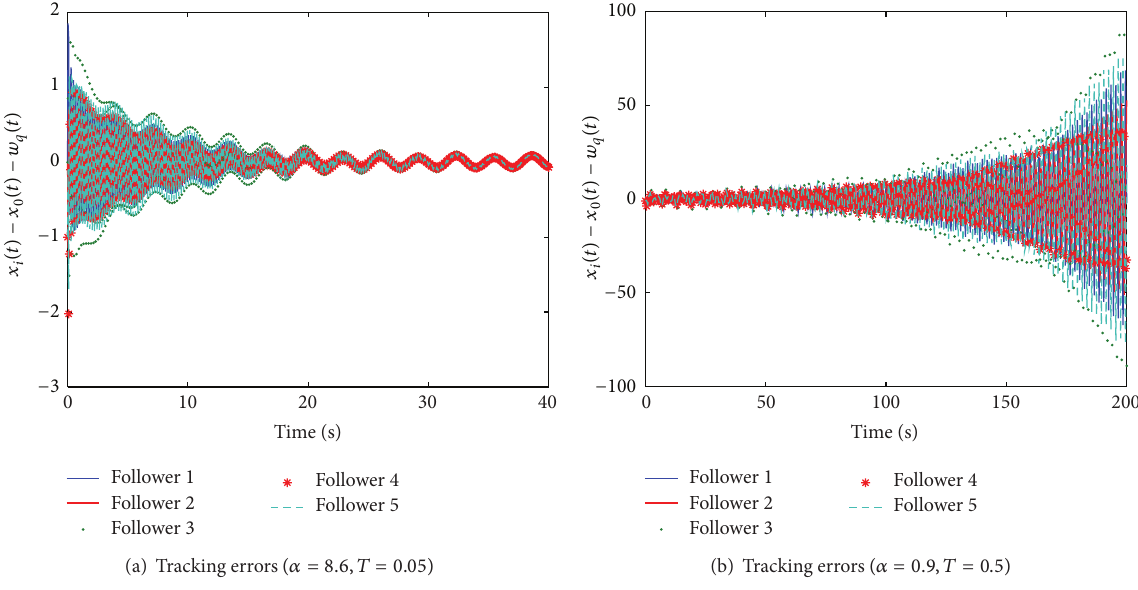
Figure 2: Tracking errors using the sampled-data protocol (9).